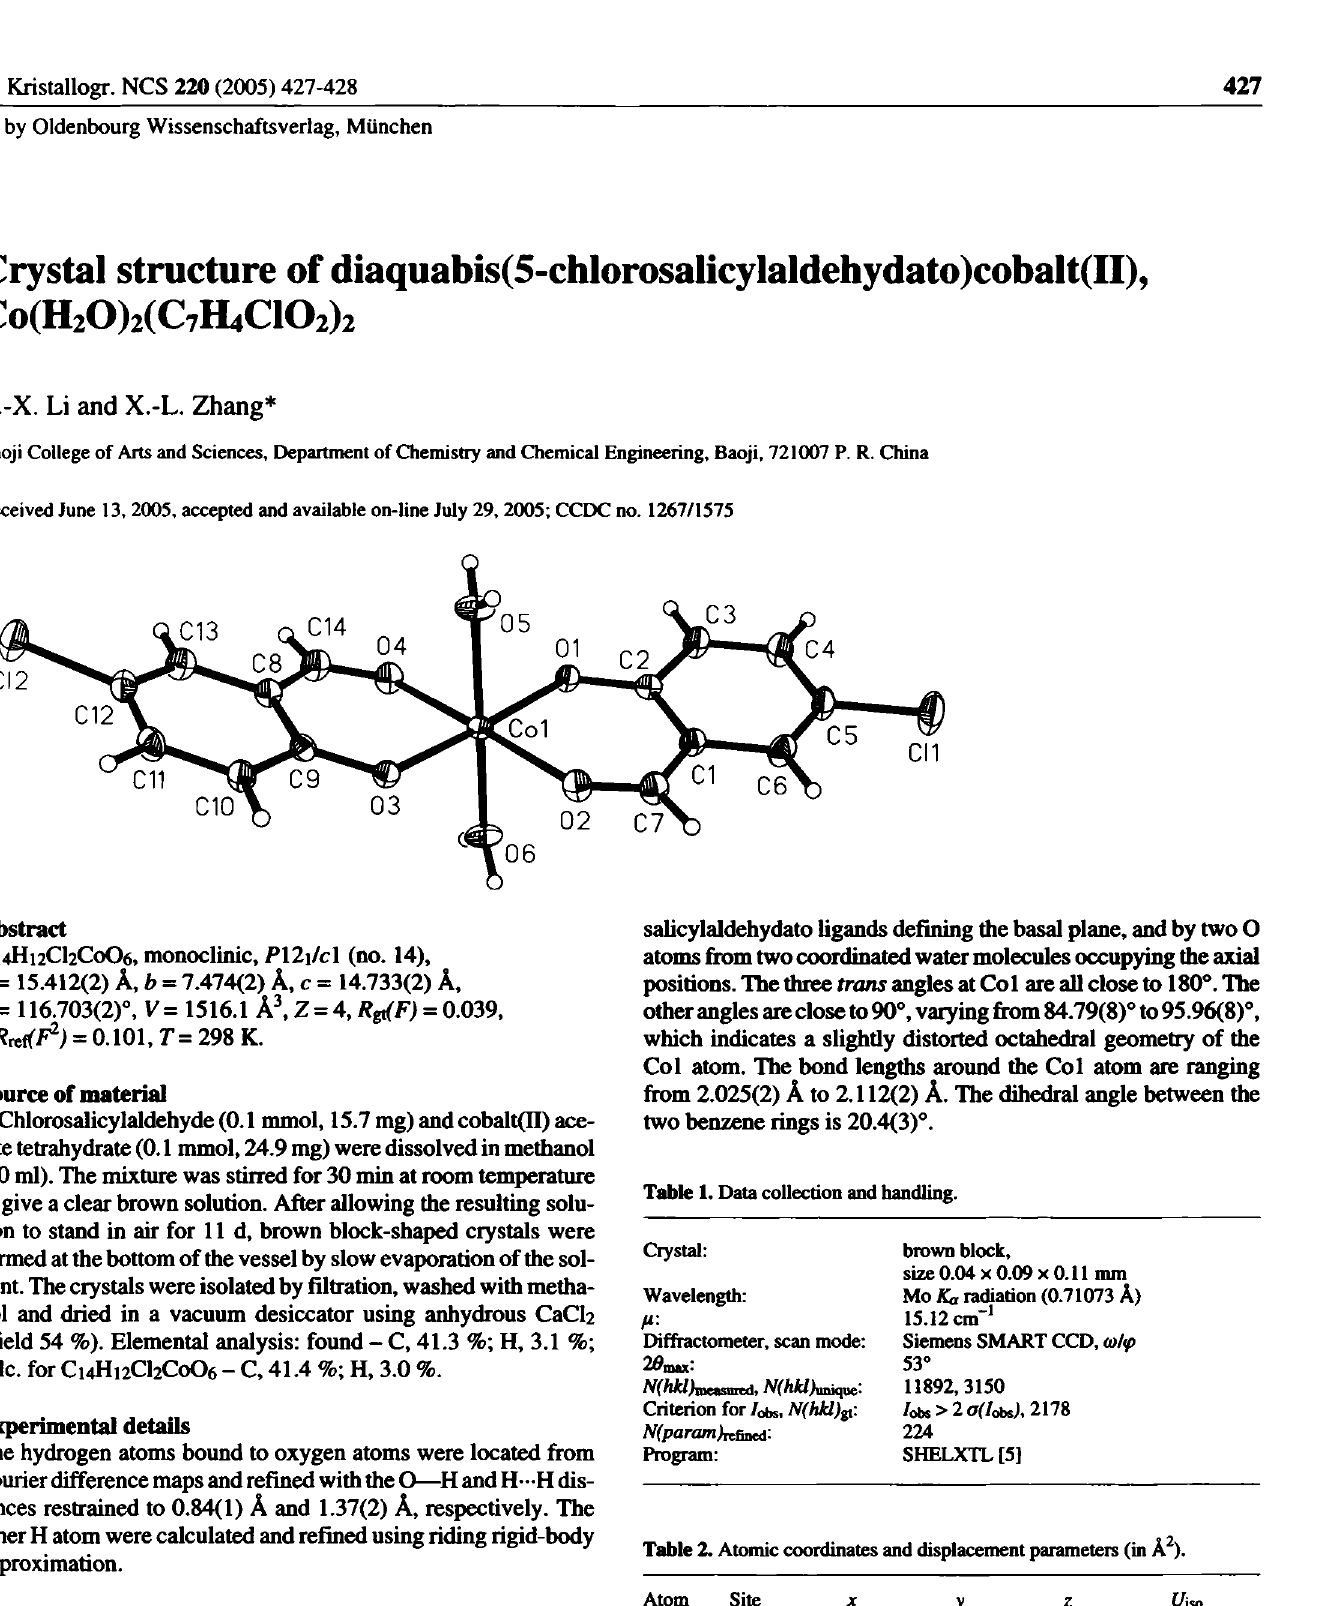
Table 2. Atomic coordinates and displacement parameters (in A 2